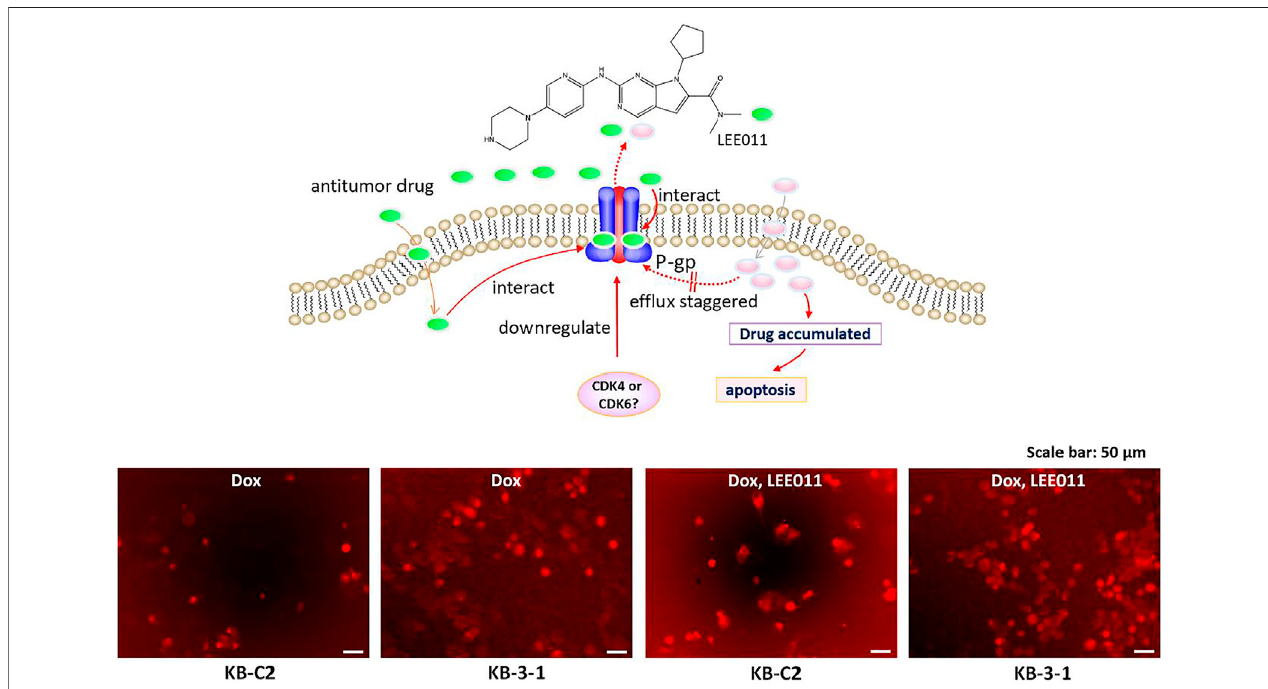
FIGURE6| Ribociclibsigni fi cantlyincreasestheaccumulationofdoxorubicin(Dox)inKB-C2cellsafter72 hofincubation,producingapoptosisornecrosis.KB-C2 and parental KB-3-1 cells were co-cultured with doxorubicin (1 µM for KB-C2 and 0.1 µM for KB-3-1) and ribociclib 1 (9 µM) for 72 h. The cells incubated with vehicle wereusedascontrols.The fl uorescenceofDoxwasimagedusing fl uorescentmicroscopy(settothered fl uorescentchannel).Theschematic fi gureshowsthatribociclib increases the accumulation of Dox by 1) decreasing its ef fl ux, which increases apoptosis and 2) downregulating the levels of P-gp protein expression which also increases the intracellular levels of